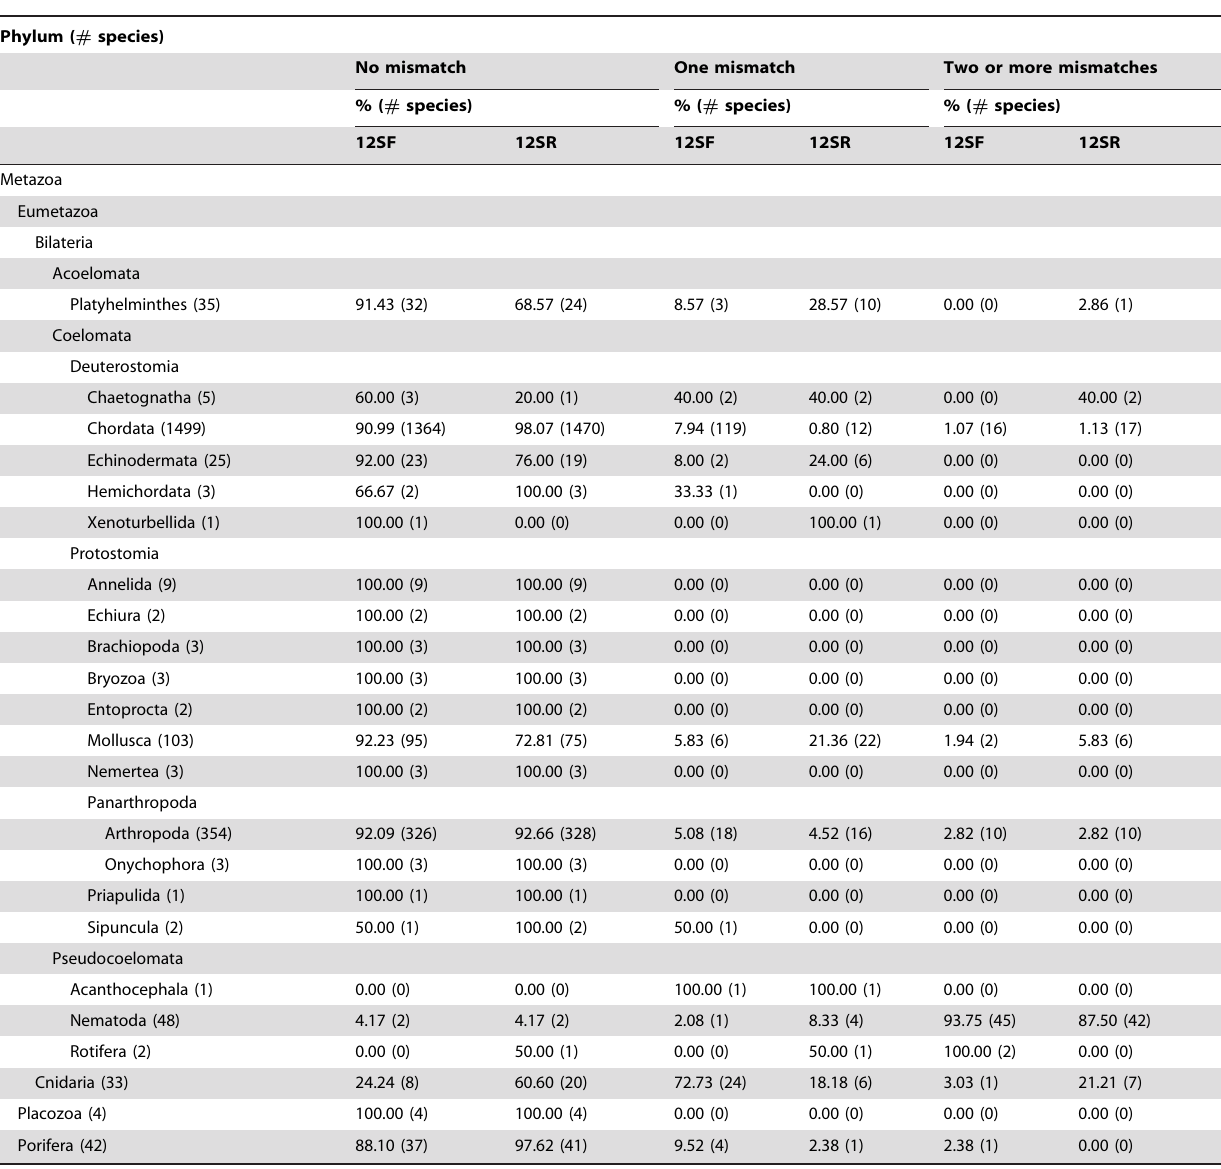
Table 1. Observed mismatches between the primer pair and the targeted region for all complete mitochondrial genome sequences downloaded from the NCBI Organelle Genome Resources